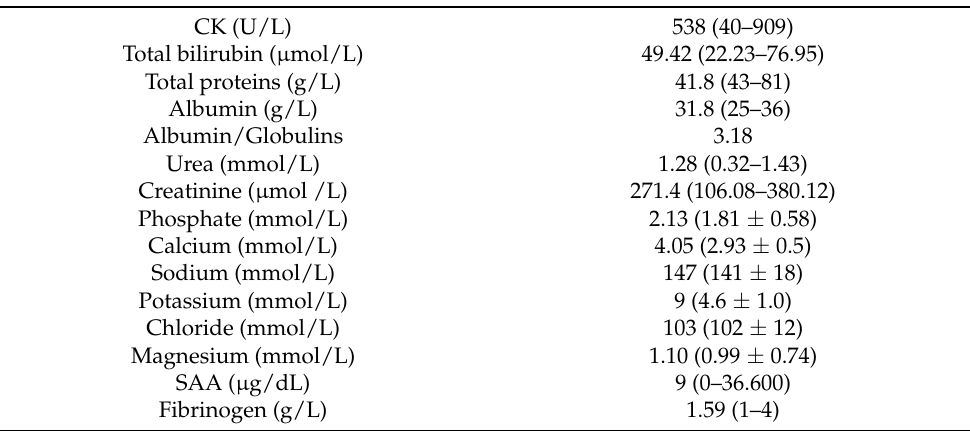
Table 2. Foal serum biochemistry and fibrinogen at birth with reference values in brackets